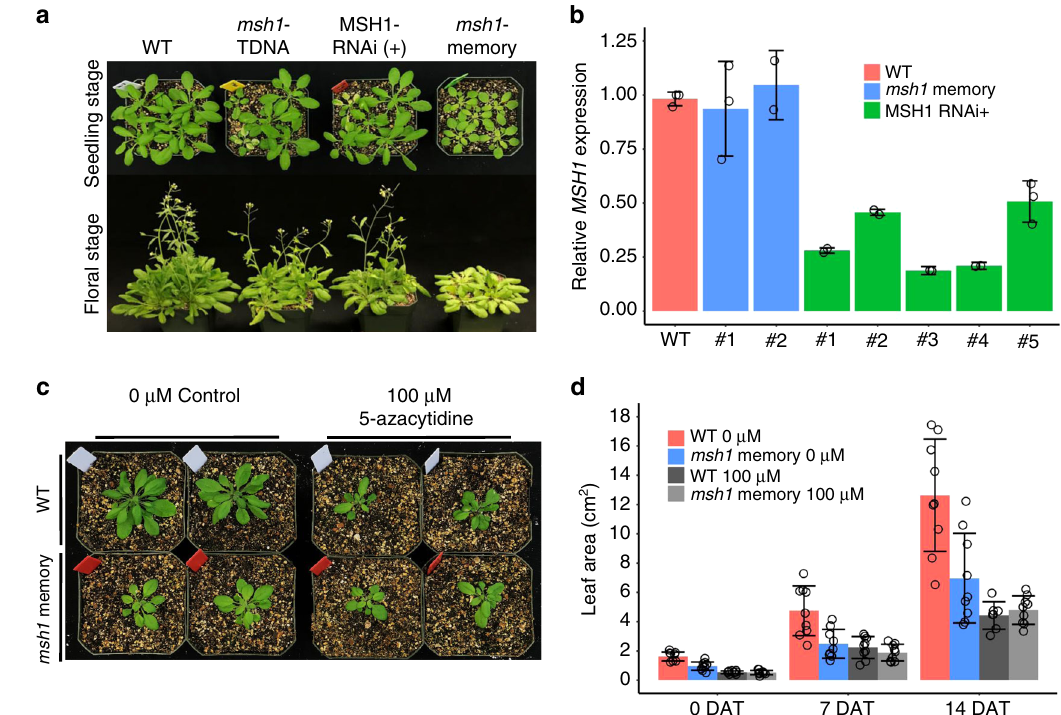
Fig. 1 MSH1 disruption produces transgenerational memory. a Phenotypic range in MSH1-derived developmental reprogramming, with msh1 memory plants uniformly reduced in growth rate, delayed fl owering and pale leaves. Seedling stage photo at 4 weeks and fl oral stage at 6 weeks. b Relative MSH1 expression levels in msh1 memory and MSH1 − RNAi line. Each column represents one individual plant, error bars represent mean ± SD; each circle represents independent result from RTPCR experiment. c Phenotype of msh1 memory line after methylation inhibitor 5-azacytidine treatment. The msh1 memory plants were grown on MS medium with 0 or 100 µ M 5-azacytidine for 10 days, then transplanted to soil; photo at 2 weeks after transplanting. d Leaf area measurements of wild type (WT) and msh1 memory plants after 5-azacytidine treatment. Each circle represents data from a single plant, bars represent means ± SD, with nine plants in each population ( n = 9). Data represent one experiment of three replicates. DAT days after transplanting. Source data underlying Fig. 1b, d are provided as a Source Data fi